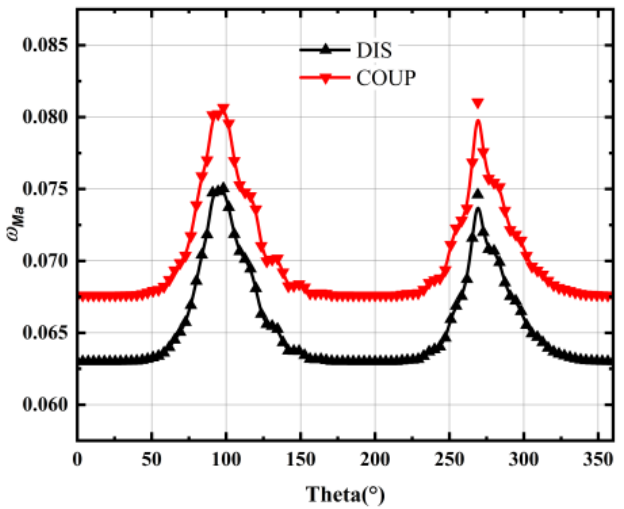
Figure 18. Comparison of the circumferential distribution of shock loss.